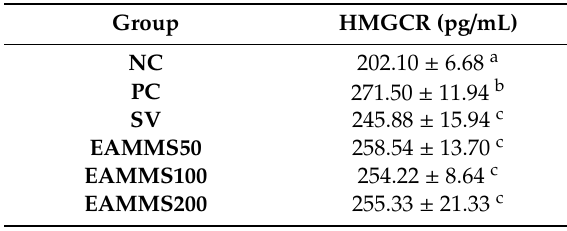
Table 6. E ff ect of ethyl acetate extract of Mikania micrantha stems (EAMMS) on HMG-CoA reductase level in experimental rats at week 8.